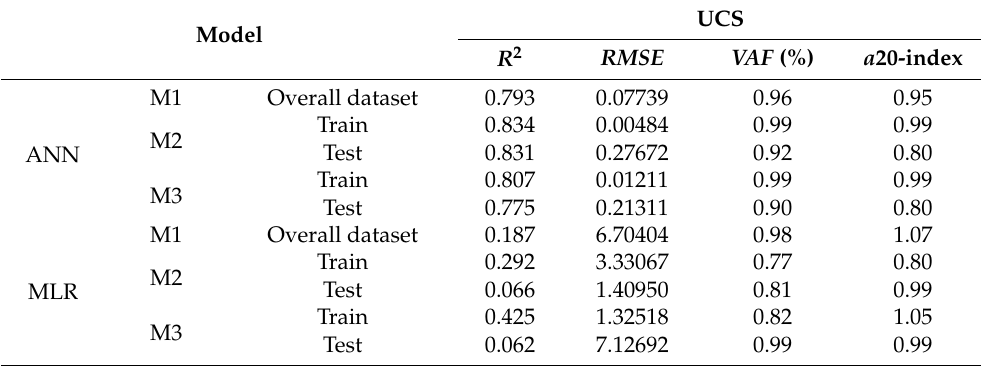
Table 5. Performance indices of the ANN and MLR models for predicting UCS for the overall dataset, training dataset, and testing dataset.